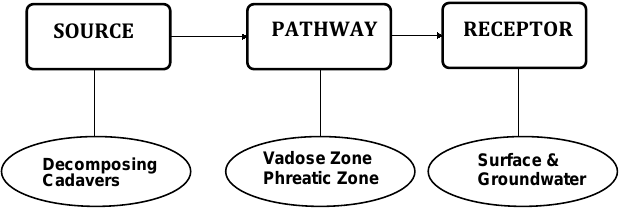
Rocks in both locations forms part of the south-western basement complex rocks. Ede is underlined by two main rock types which include pegmatite and Schist. The pegmatites, which occur as near vertical dykes, strike primarily in the direction of NNE-SSW intrudes the older banded gneiss lithology. Banded gneiss occurs as a massive rock consisting of alternating felsic mineral bands, especially plagioclase feldspars and quartz, and dark biotite and hornblende bands. Two main lithologies underlie Iragbiji area which includes granite-gneiss and schist. The geology of the area is presented in Fig. 3 modified after Oyelami and Van Rooy (2016b). The soils within the study areas belong to the highly ferruginous tropical red soils (lateritic) associated with basement complex rocks. As a result of the dense humid forest cover in the area and the distinct wet and dry seasons prevalent in the area. The soils are generally deep and of two types, namely, deep clayey soils formed on low smooth hill crests and upper slopes; and the sandy hill wash soils on the lower slopes (Bamiji, 2012).